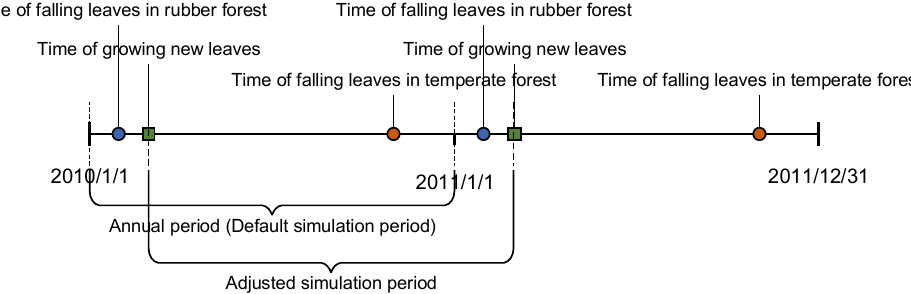
Figure 6. Phenology of rubber plantations and temperate deciduous broad-leaved forests, and the adjustments to simulation periods.